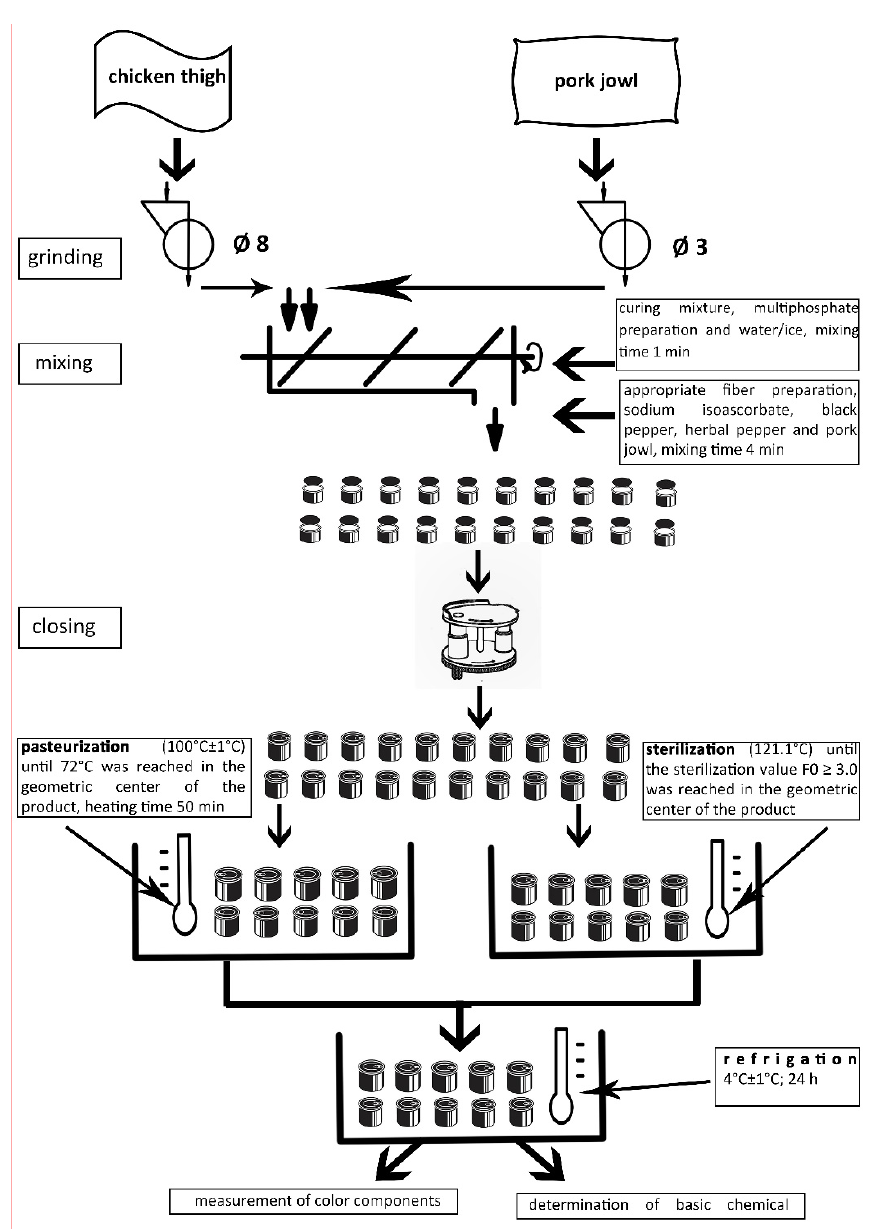
Figure 1. Scheme of the production process of medium-grounded pasteurized and sterilized model canned meat products.